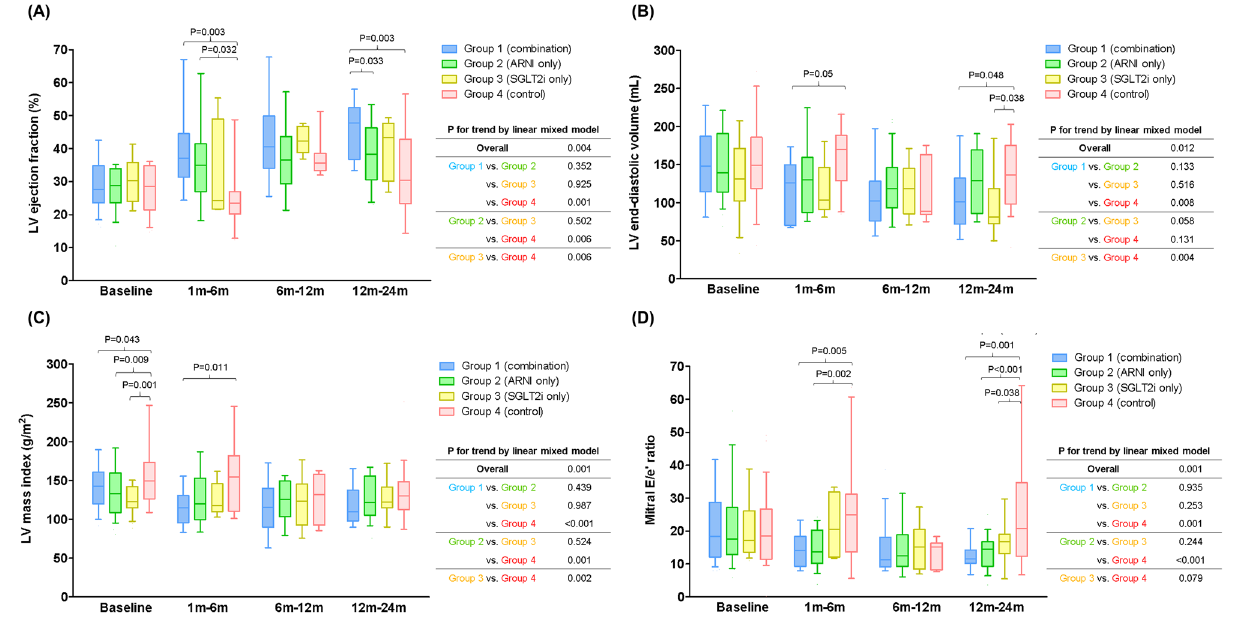
Figure 3. Changes of serial echocardiographic measurements based on groups. The serial measurements of ( A ) LV ejection fraction, ( B ) LV end-diastolic volume, ( C ) LV mass index, and ( D ) mitral E/e ′ ratio are plotted according to the